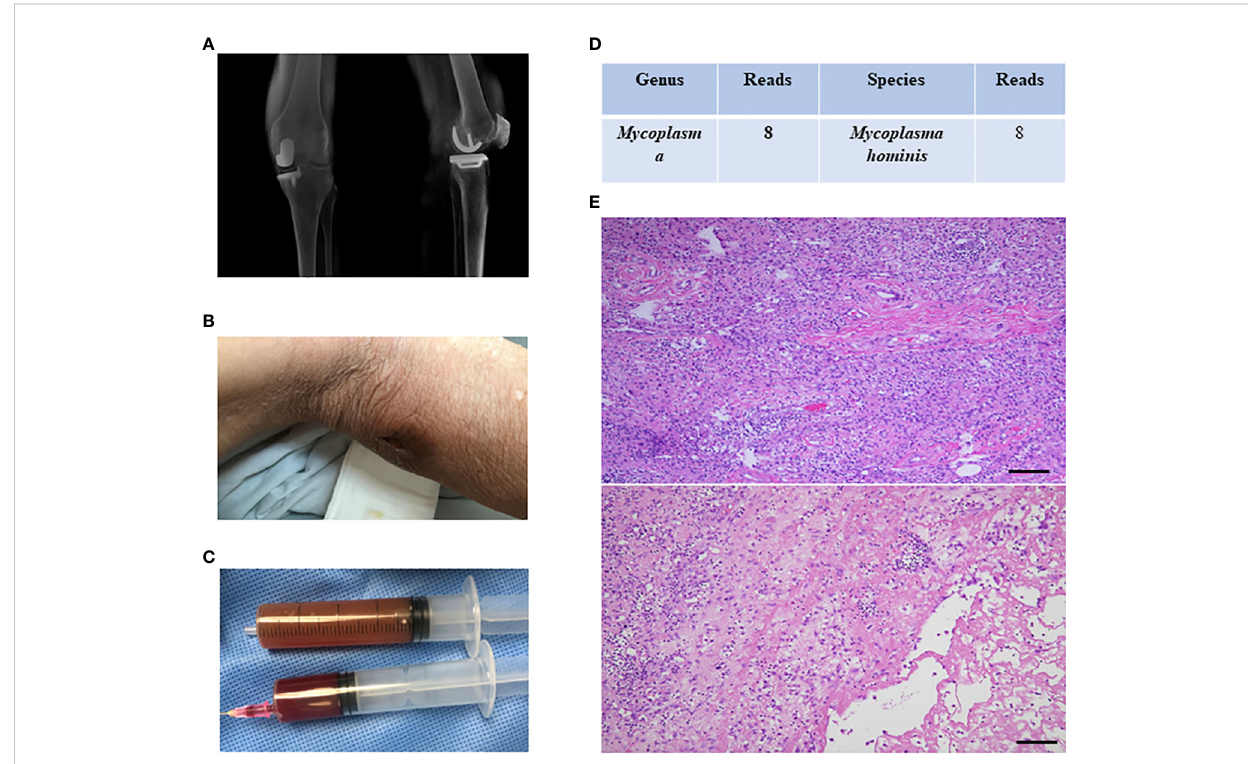
FIGURE 1 The clinical data of case 5. (A) the imaging data of case 4; (B) there was a sinus tract behind the knee; (C) purulent synovial fl uid was obtained from preoperative aspiration; (D) mNGS indicated Mycoplasma hominis infection; (E) intraoperative pathological test showed there were a large amount of neutrophils in periprosthetic